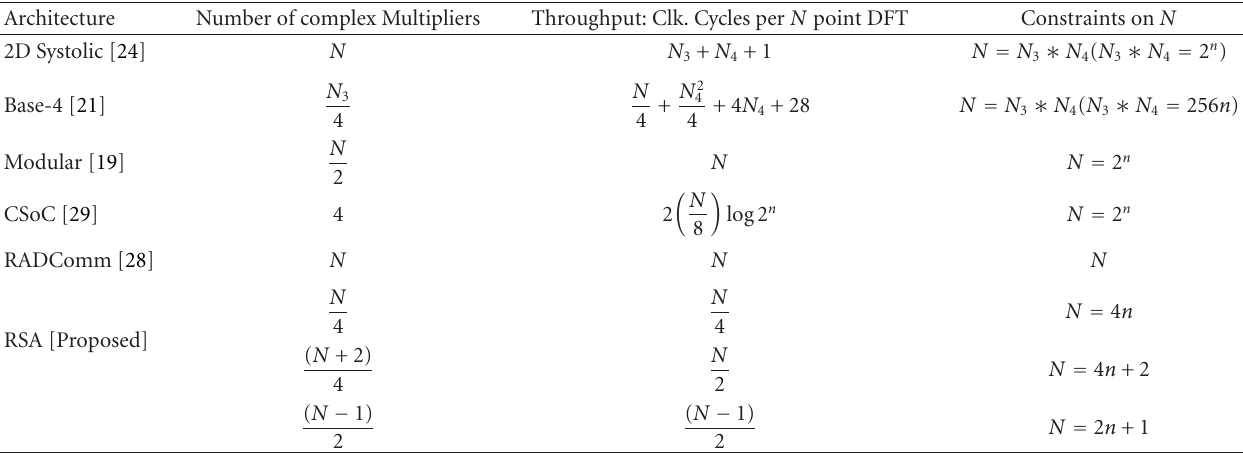
Table 2: Throughput and complex multiplier requirements for reconfigurable DFT